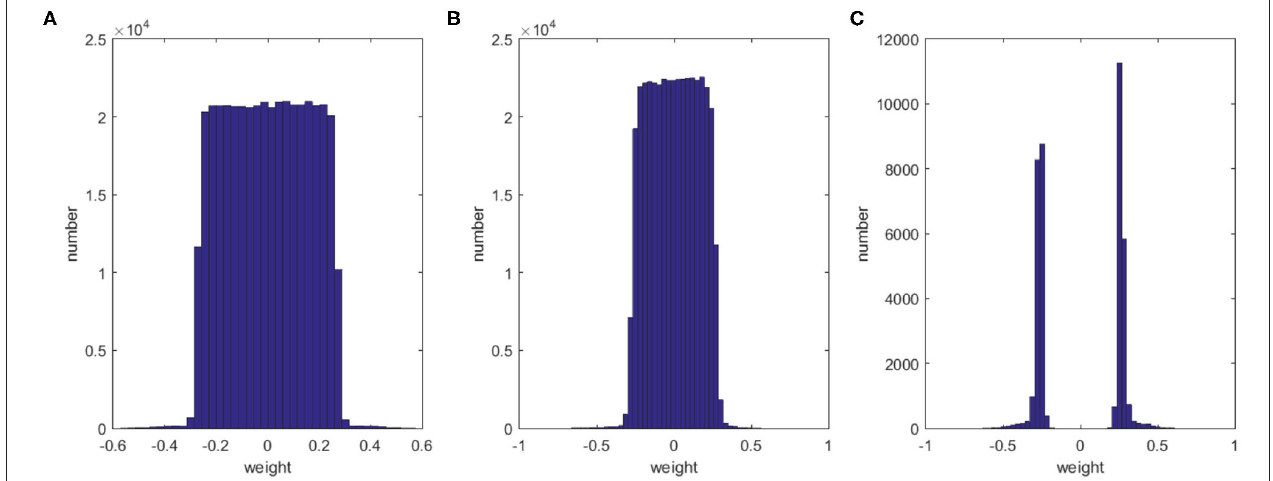
FIGURE 4 | Histograms showing the distribution of weights for the initial network (A) , the dropout network (B) , and our method (C)